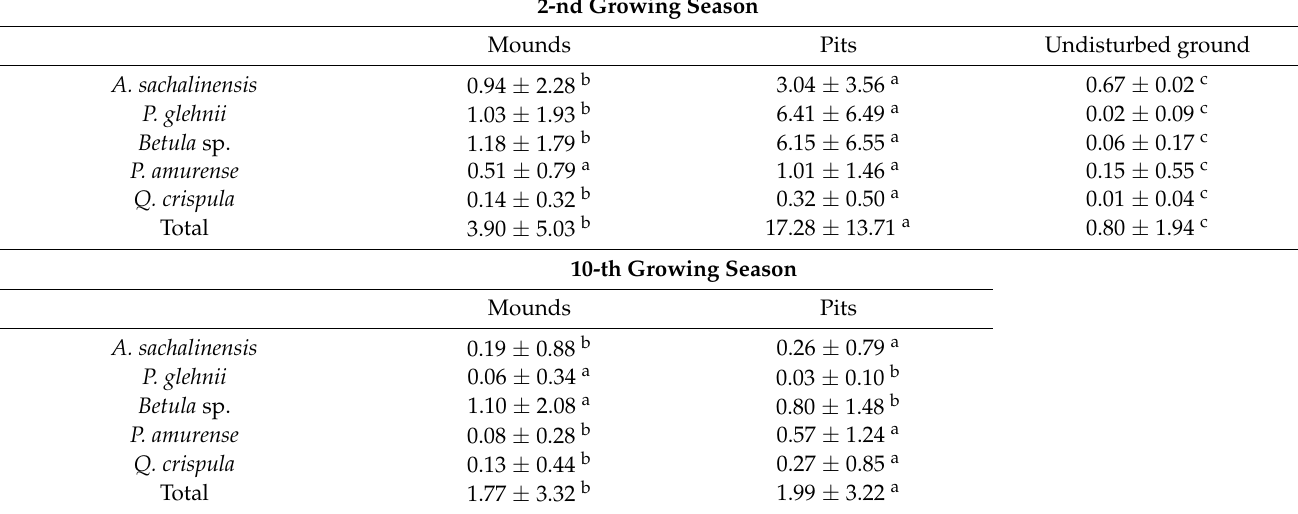
Table 3. Seedling density (m − 2 ) of the major tree species in the 39 microtopographies (mounds and pits) induced by the strong wind, and the undisturbed ground. The averages and standard deviations measured in the 2-nd and 10-th growing seasons are